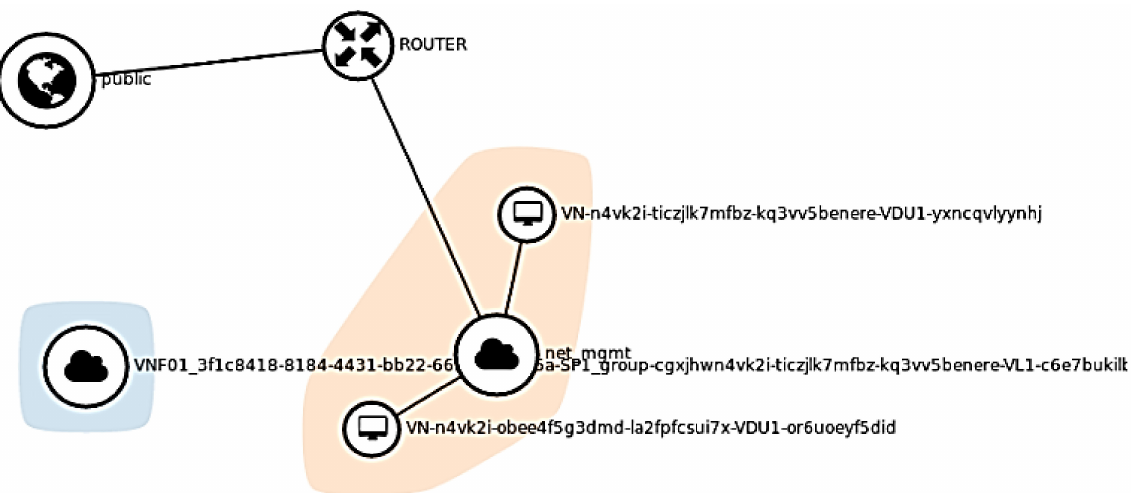
Figure 16. Network Topology for VNF